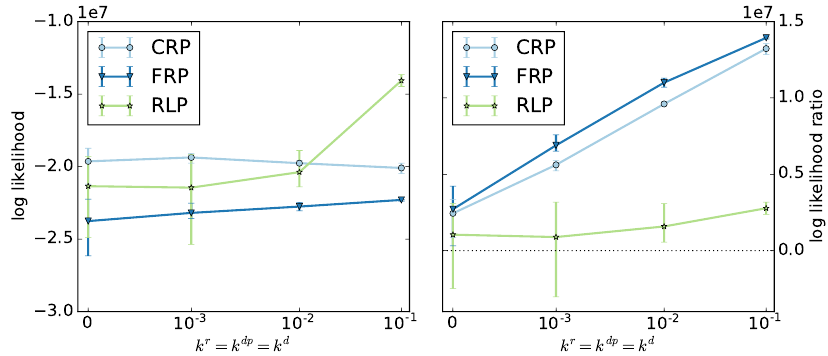
Figure 6. Log likelihoods ( left ) and log likelihood ratios ( right ) of the results from the optimizations using the ODE fingerprint-generating function for the controlled radical polymerization (CRP), free radical polymerization (FRP), and reversible living polymerization (RLP) as a function of termination and depropagation